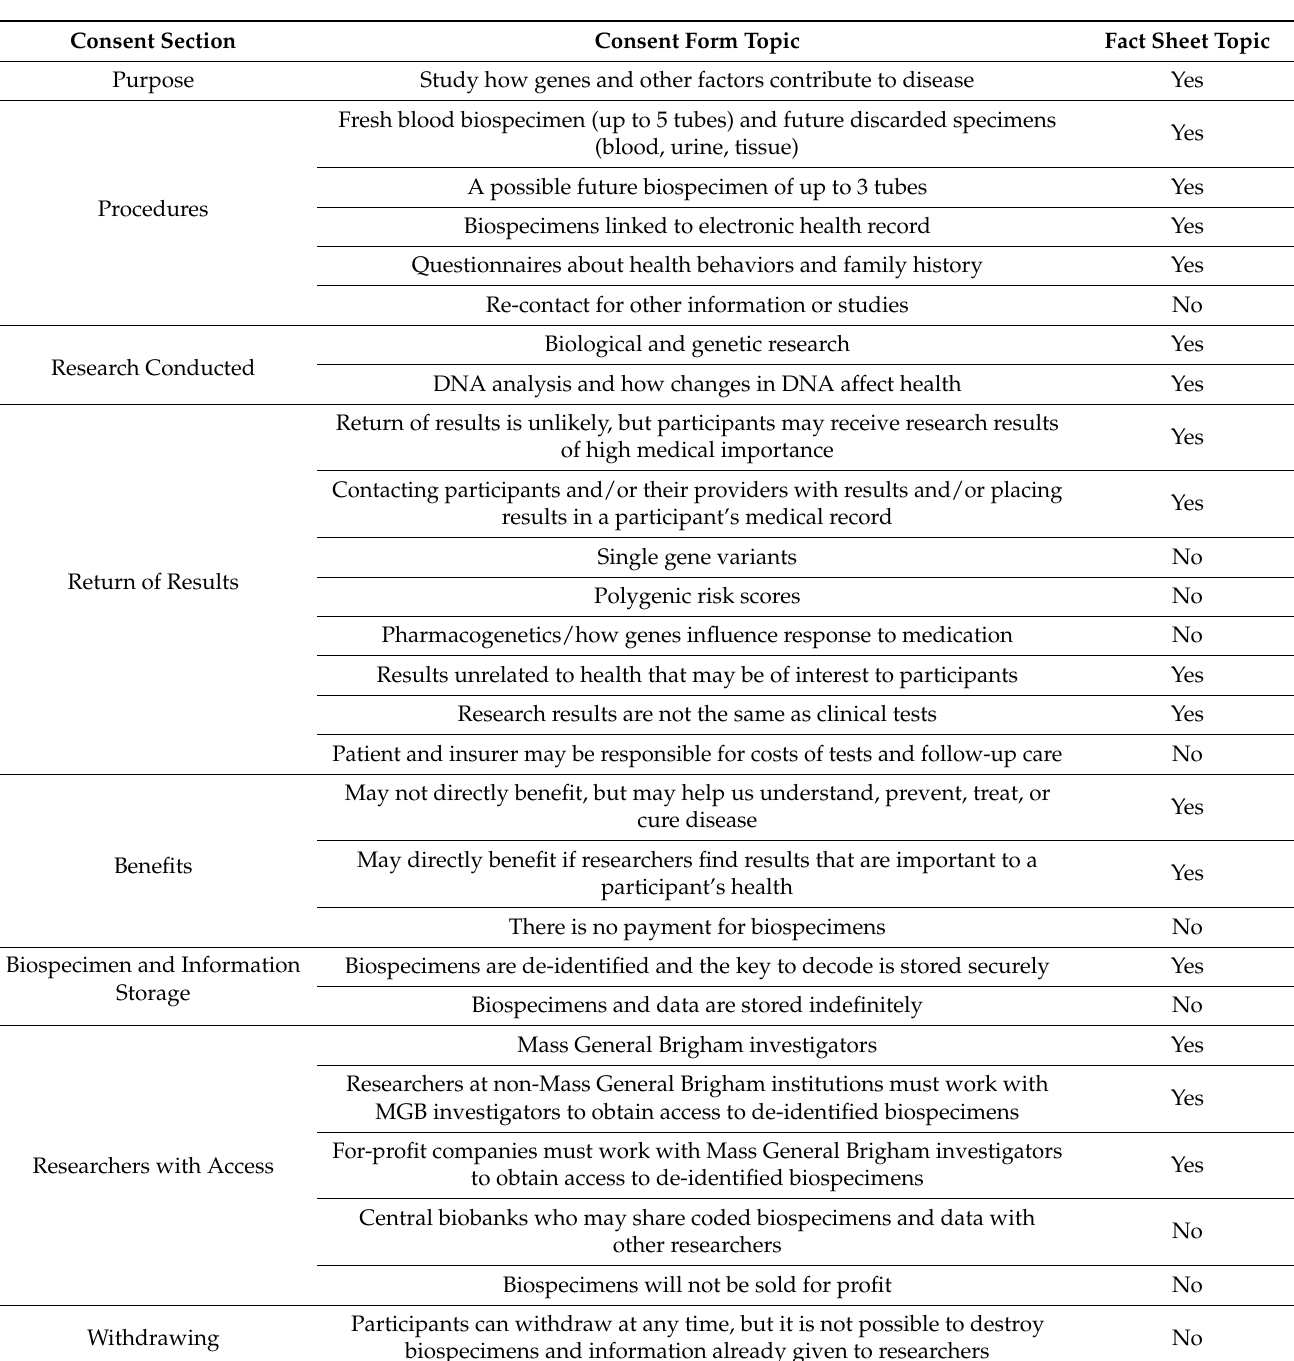
Table 2. Key elements of MGB Biobank informed consent form and fact